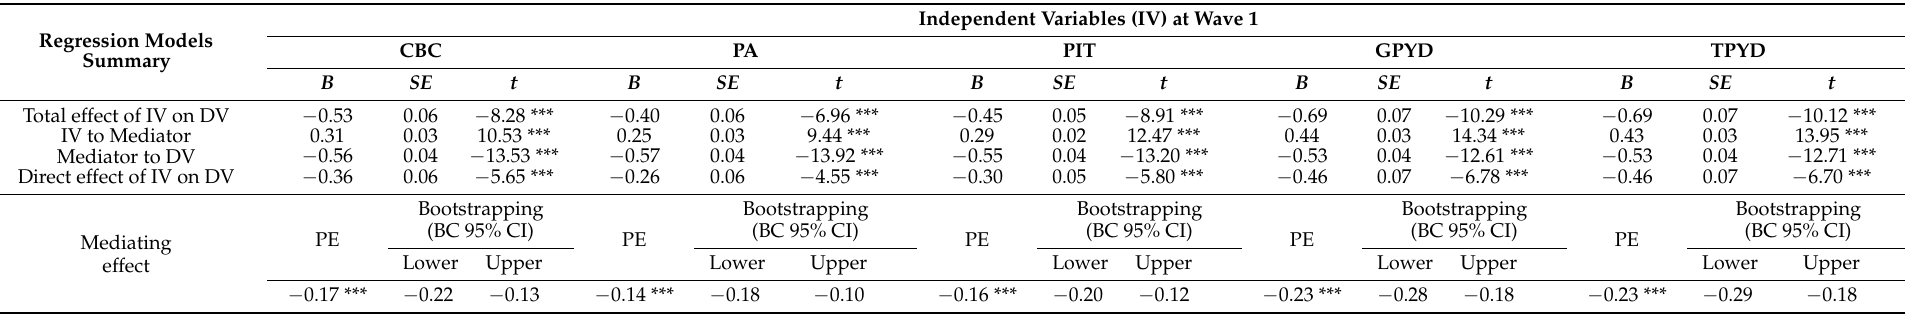
Table 7. Longitudinal mediating effect analyses of life satisfaction at Wave 2 (the mediator) for the effect of PYD measures at Wave 1 on Internet addiction at Wave 2. Regression Models